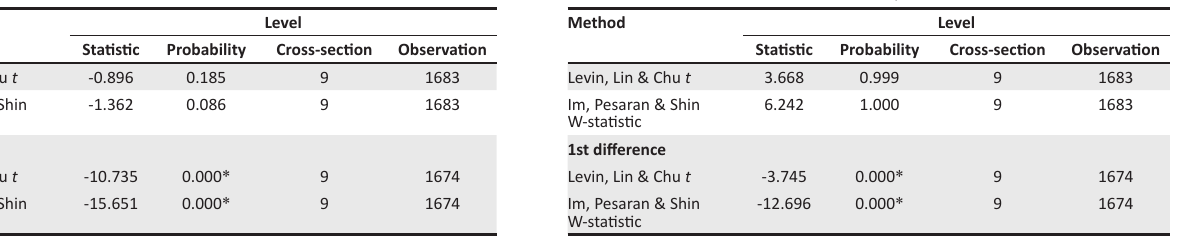
TABLE 6: Panel unit root test: G7 Industrial